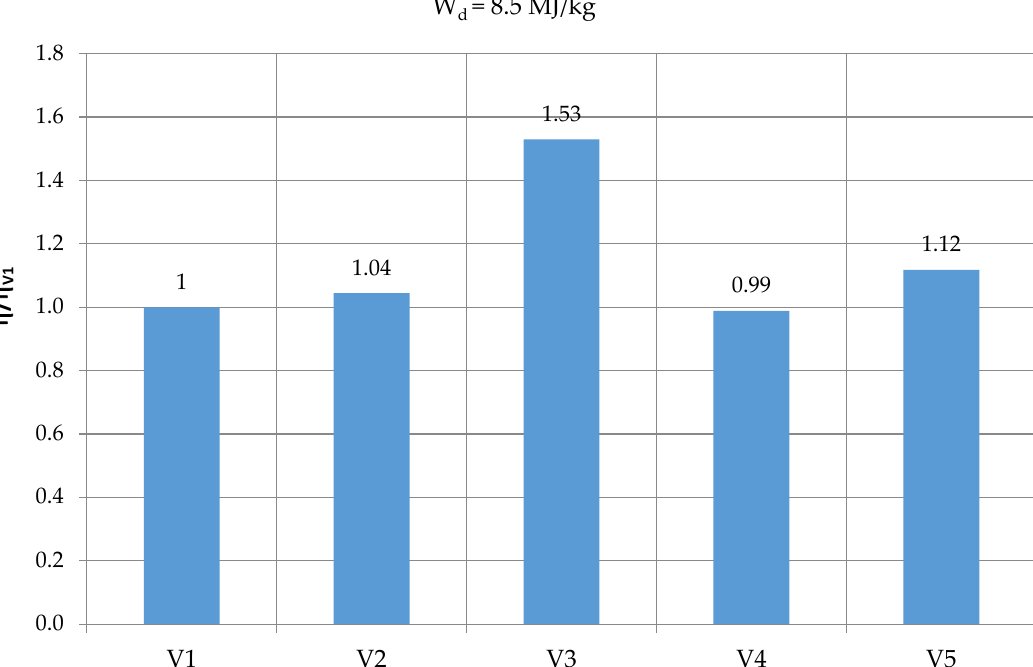
Figure 6. The effect of the cycle structure on its as compared to variant 1 for heating value W d = 17.5 MJ/kg.